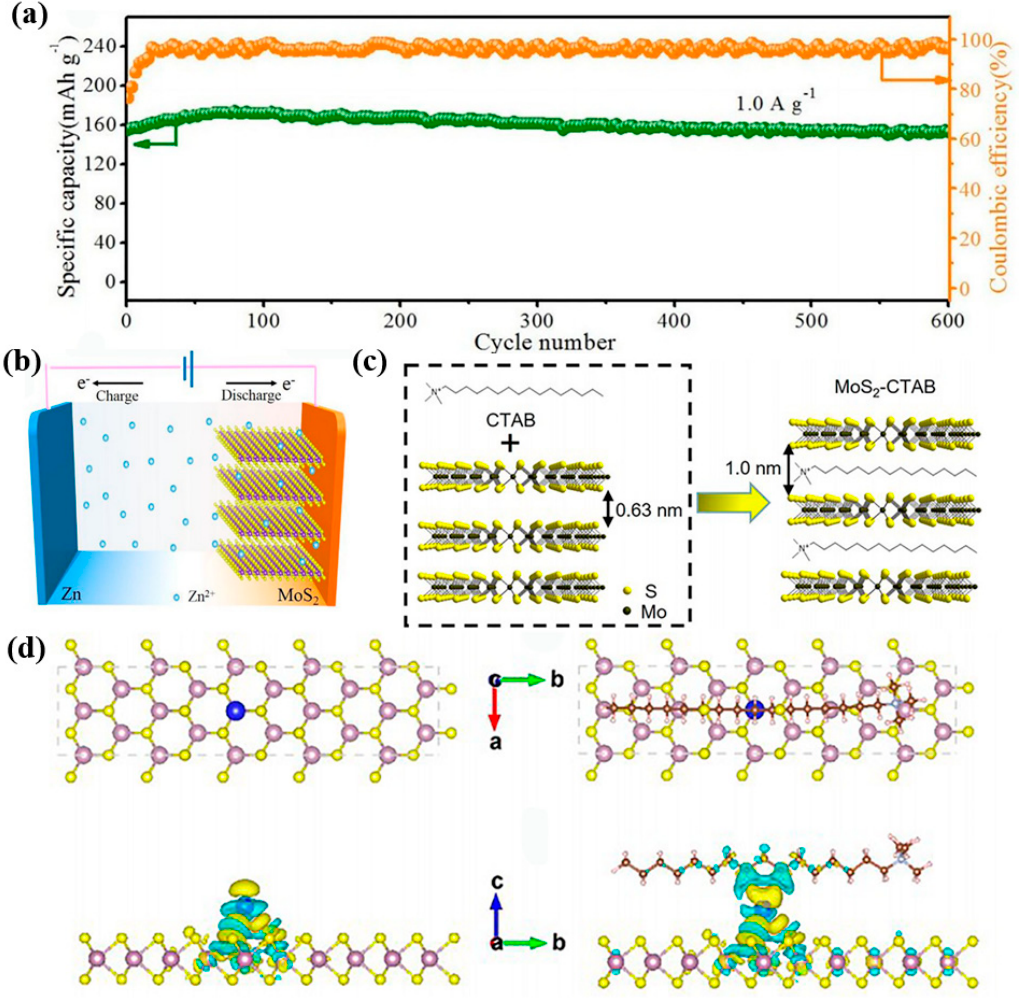
Figure 4. The modification of MoS 2 materials and DFT calculation. ( a ) Cycling stability of Zn/E–MoS 2 batteries at 1.0 A g − 1 . ( b ) Schematics of the mechanism of batteries. Reproduced with permission